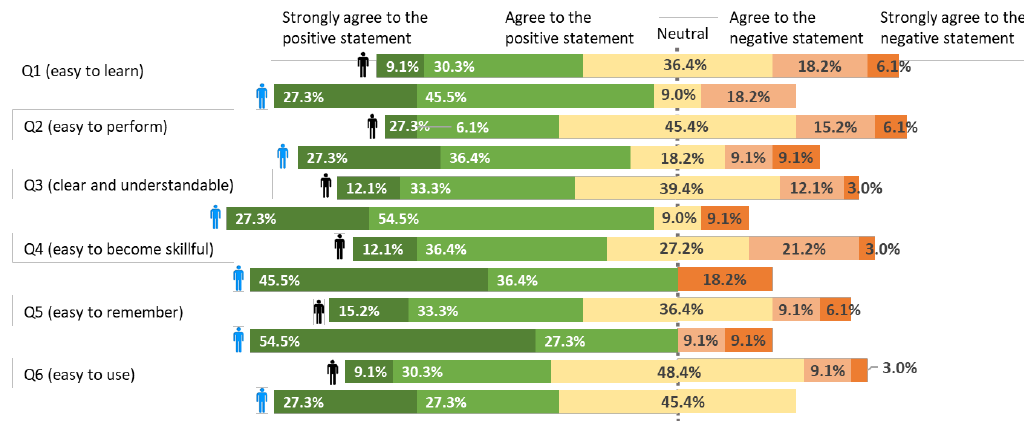
Fig. 16. Perceived ease of use of USINN as basis for creating